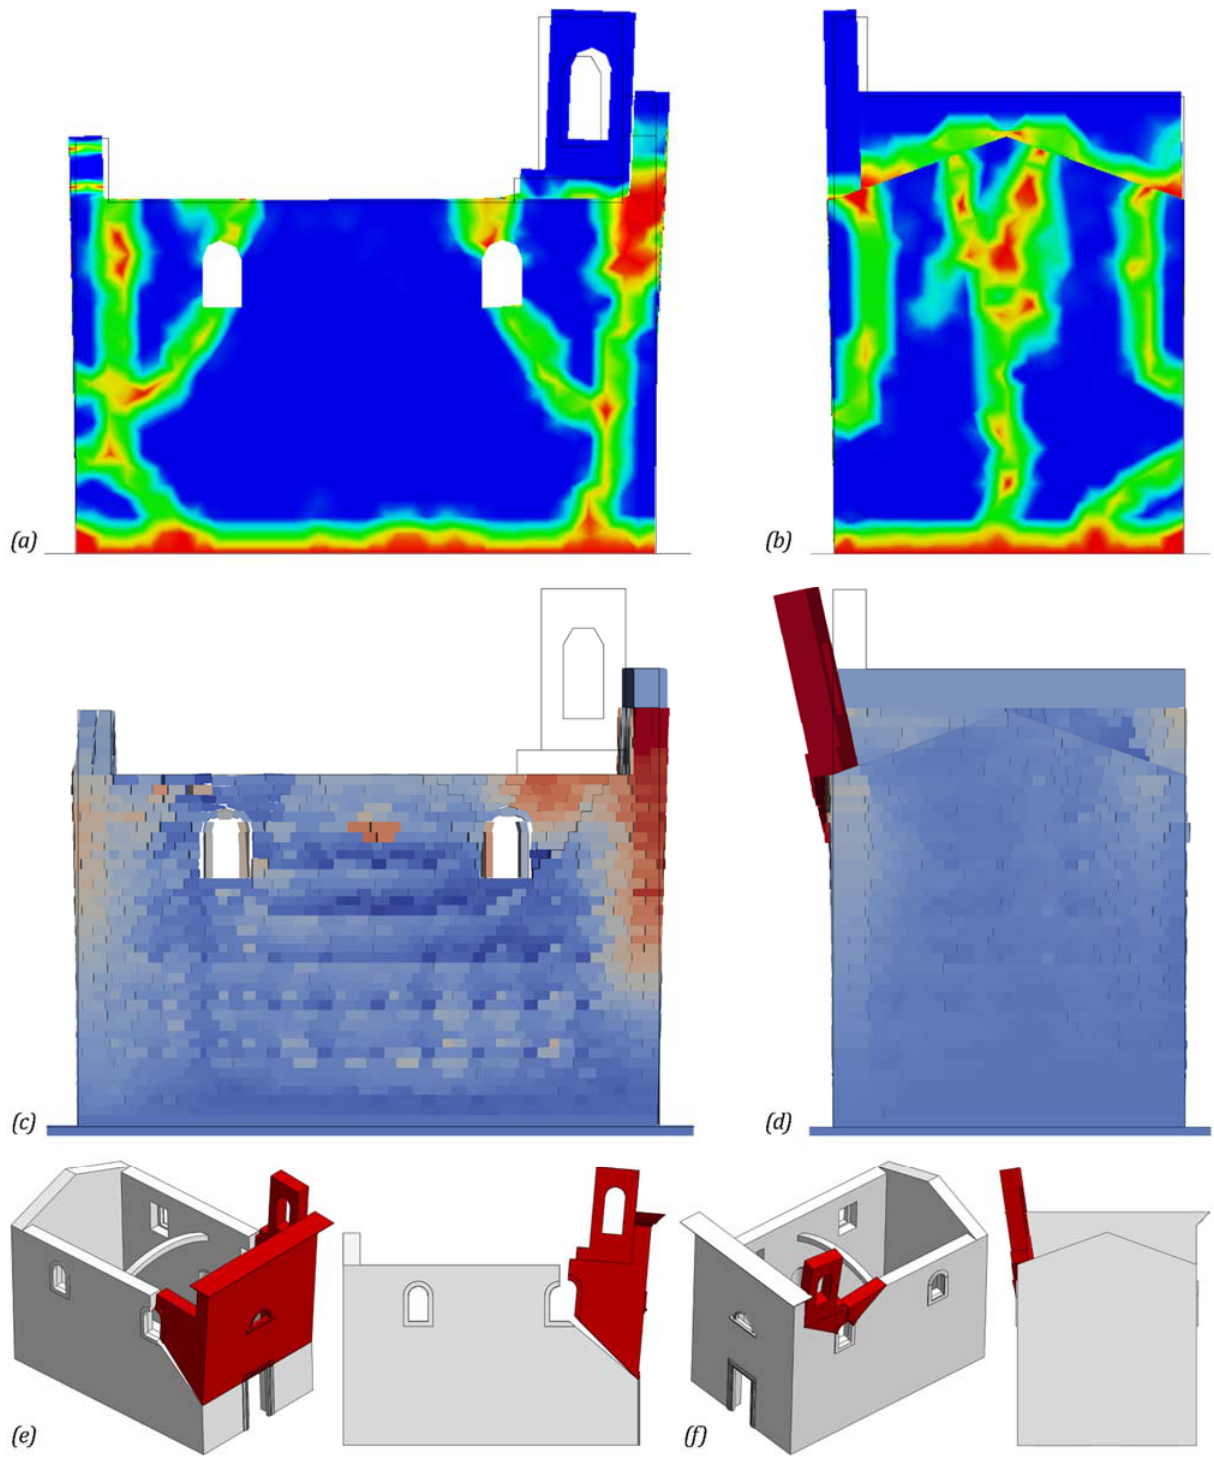
Figure 17. Views of the activated failure mechanisms from the nonlinear dynamic analyses performed under the epicentral seismic actions by means of ( a , b ) the CDP and ( c , d ) the NSCD methods respectively for the overturning of the ( e ) main façade and the ( f ) steeple.